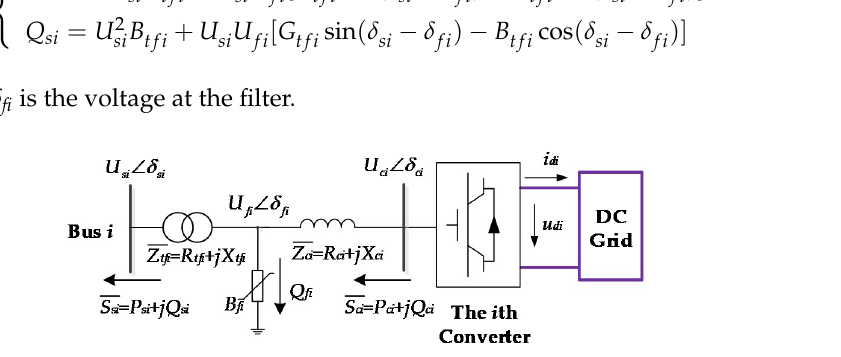
Figure 1. Steady-state model of a Voltage Source Converter (VSC) station.